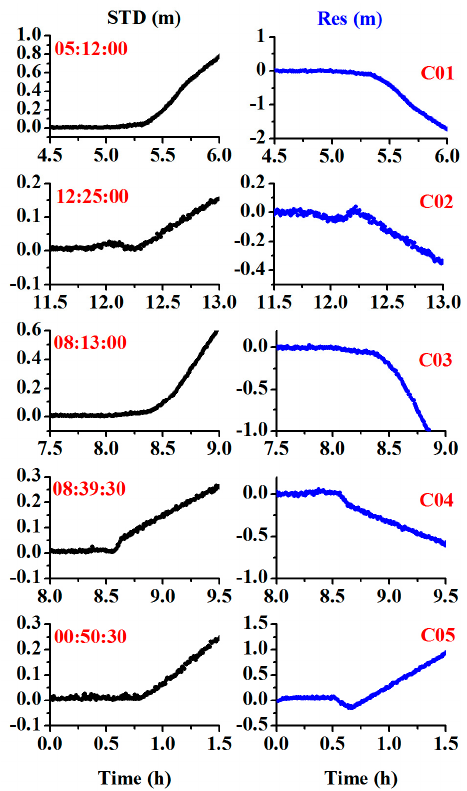
Figure 14. Time series of the STD of the observation residuals and array L for the geostationary orbit (GEO) satellites showing orbital maneuver (the left side represents the time discriminant factor, and the right side represents the satellite identification factor).